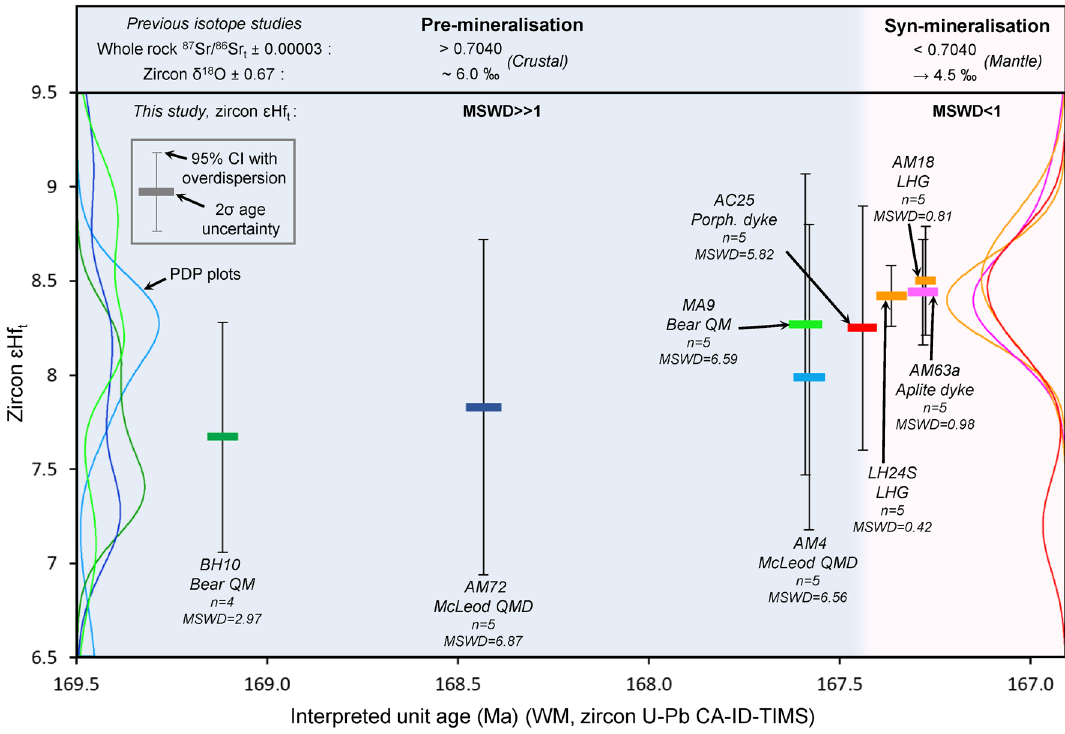
Figure 8. Zircon ɛ Hf t through the Yerington magmatic system: Time corrected zircon ɛ Hf ( ɛ Hf t ) versus interpreted unit age for samples spanning the Yerington magmatic system. Age determinations for each unit are the weighted mean (WM) from zircon single grain U–Pb CA–ID–TIMS analyses (Fig. 4). ɛ Hf t error bars at 95% confidence interval (CI) with overdispersion. ‘Pre-’ and ‘inter-mineralisation’ fields shaded. Probability density plots (PDP) inset, coloured as per sample. From the MSWD data for ɛ Hf t , ‘pre-mineralisation’ units show over dispersion (MSWD > 1) and ‘syn-mineralisation’ units show under dispersion (MWSD < 1). Data compared to previous whole rock 87 Sr/ 86 Sr t 27 and zircon δ 18 O 36 isotope studies, which show subtle shifts from crustal to mantle isotopic signatures 73–75 . All data points plotted in Fig.